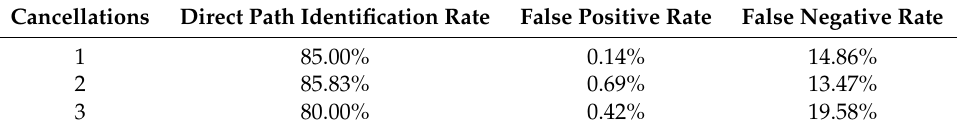
Table 5. Direct path identification rate of NC-MUSIC in UMi scenario.